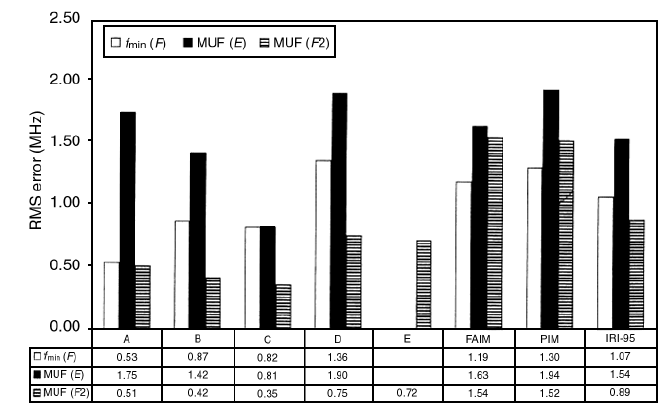
Fig. 7. Histograms of RMS errors in the estimation of the maximum useable frequency showing that use of to- mographic images gives smaller errors for F 2-layer MUF than the FAIM, PIM and IRI 95 models. From Rogers et al. (2001), reproduced by permission of the American Geophysical